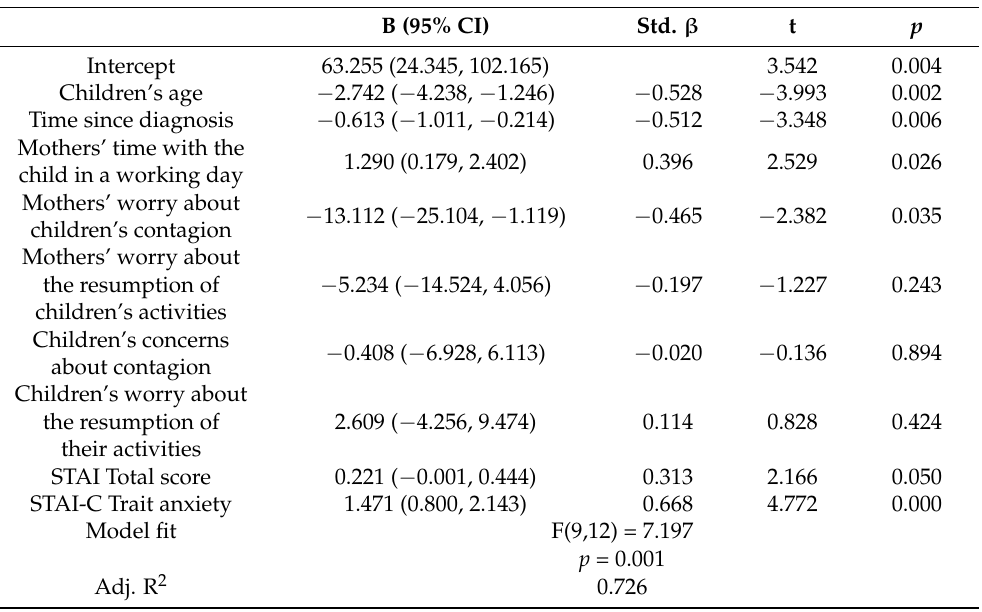
Table 4. Multiple linear regression model of cancer-afflicted children’s separation anxiety symptoms ( n = 33). B, unstandardized beta; Std. β , standardized beta; CI, confidence intervals; Adj. R2, adjusted R-squared; p < 0.05 in